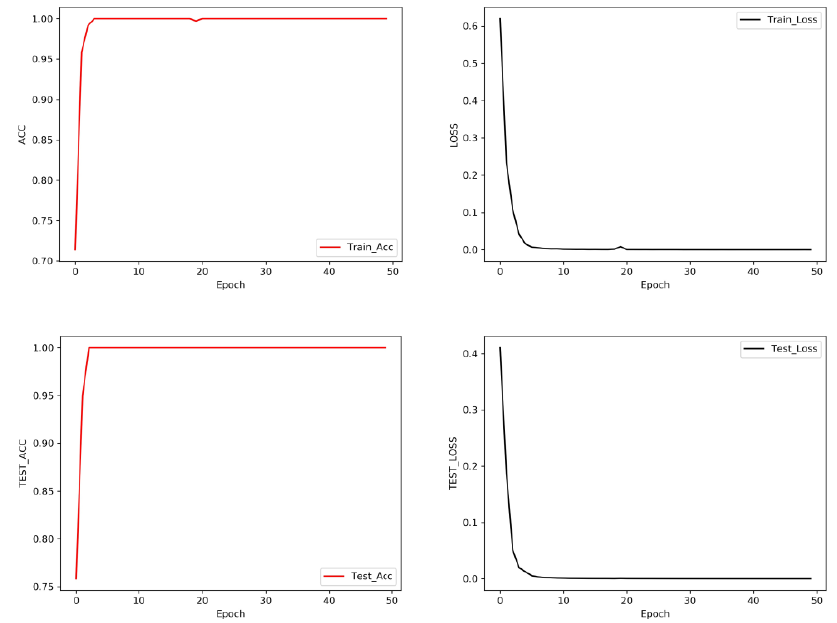
Figure 6. Training accuracy, training loss, test accuracy and test loss of CNN for bearing diagnosis.